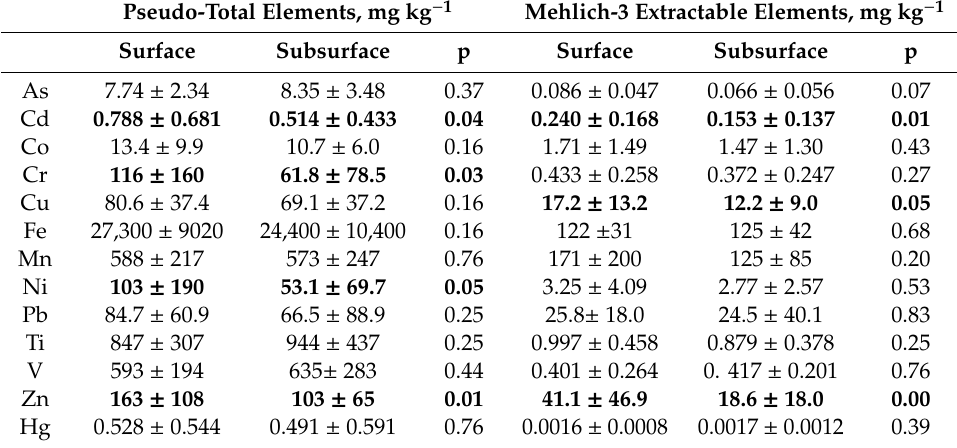
Table 6. Mean values and standard deviations of the concentrations (mg kg − 1 ) of pseudo-total and Mehlich-3 extractable PTEs from surface (n = 35) and subsurface (n = 56) horizons of the urban soils studied and significance of equality of means (T-test). Significant di ff erences (p ≤ 0.05) highlighted in